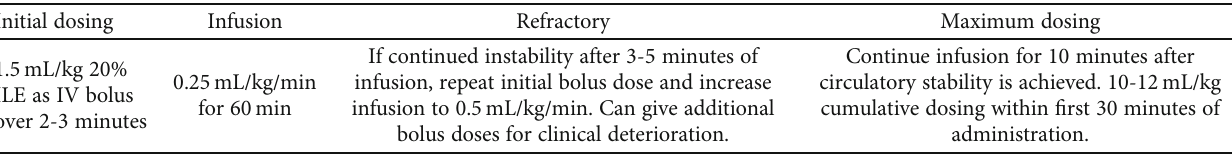
Figure 1: (a) Child 1 rhythm strip on presentation. (b) Child 1 electrocardiogram (EKG) on pediatric intensive care unit admission. (c) Child 2 EKG in emergency department. (d) Child 2 EKG following magnesium administration. Table 1: 20% intravenous lipid emulsion dosing recommendations [20 –